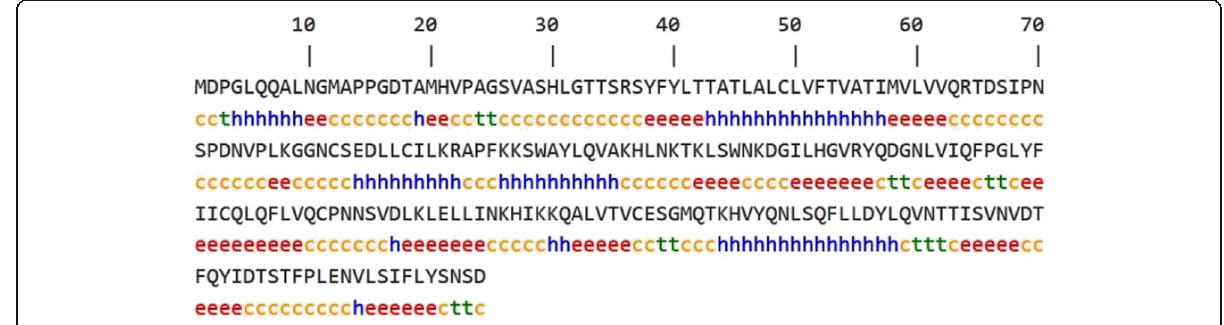
Fig. 4 The predicted secondary structure of TNFL8. h= alpha-helix; e= extended strand; t= beta-turn; c= random coil